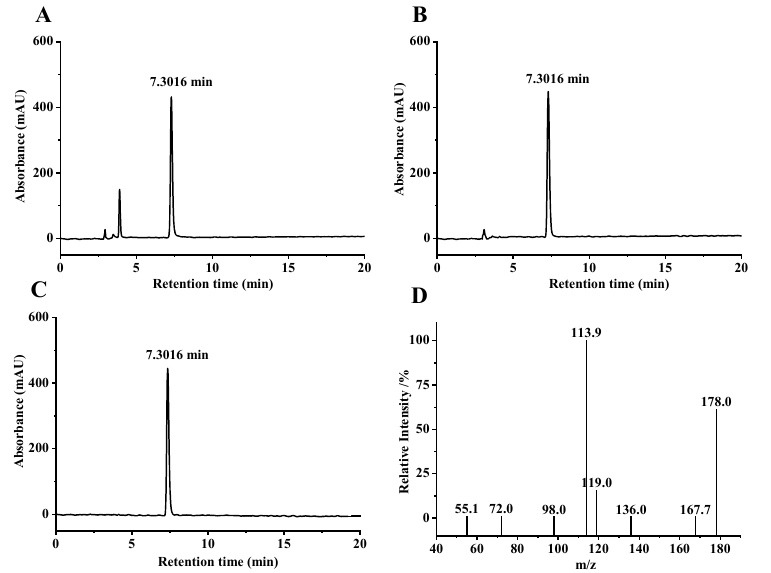
Figure 1. High-performance liquid chromatogram (HPLC) chart of crude sulforaphane (SFN) extract derived from broccoli seeds. ( A ), standard SFN ( B ), purified product ( C ), and secondary mass spectrum ( D ).